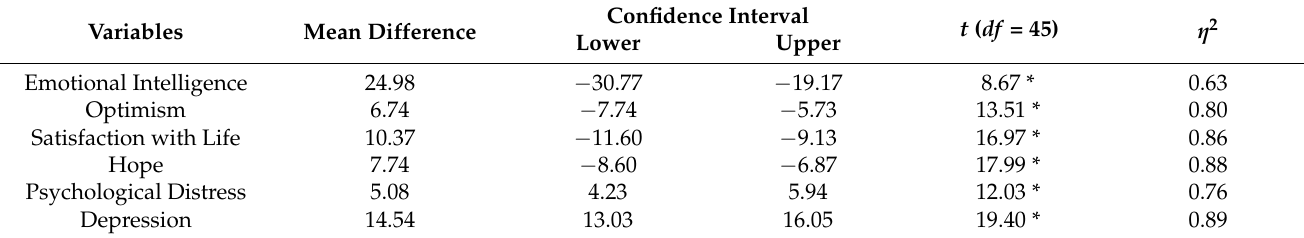
Table 6. Results of paired-samples (repeated measures) t -test (study 2).